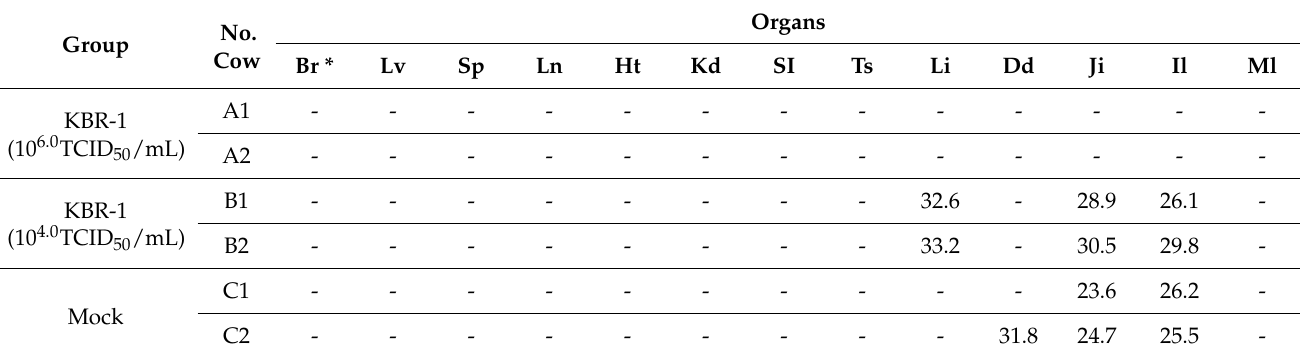
Table 5. Detection of BCoV in organs of vaccinated calves challenged with BCV